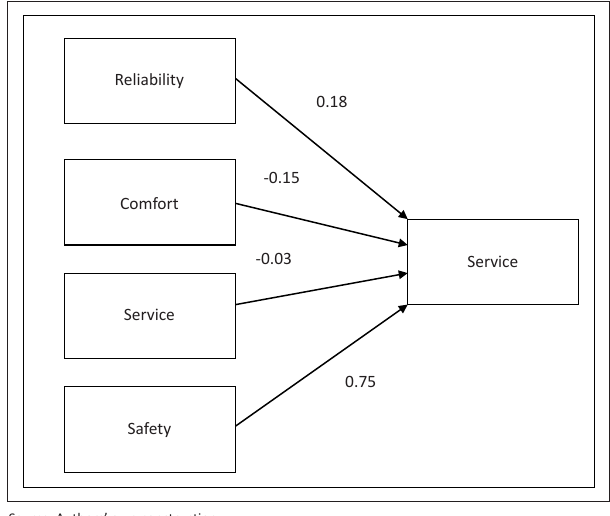
FIGURE 2: Revised conceptual public bus service quality model. TABLE 4: Regression weights – public bus services. Service quality